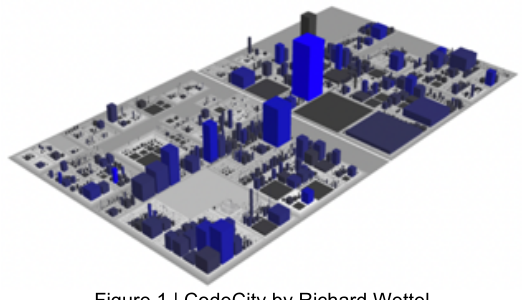
Figure 1 | CodeCity by Richard Wettel Packages are represented as